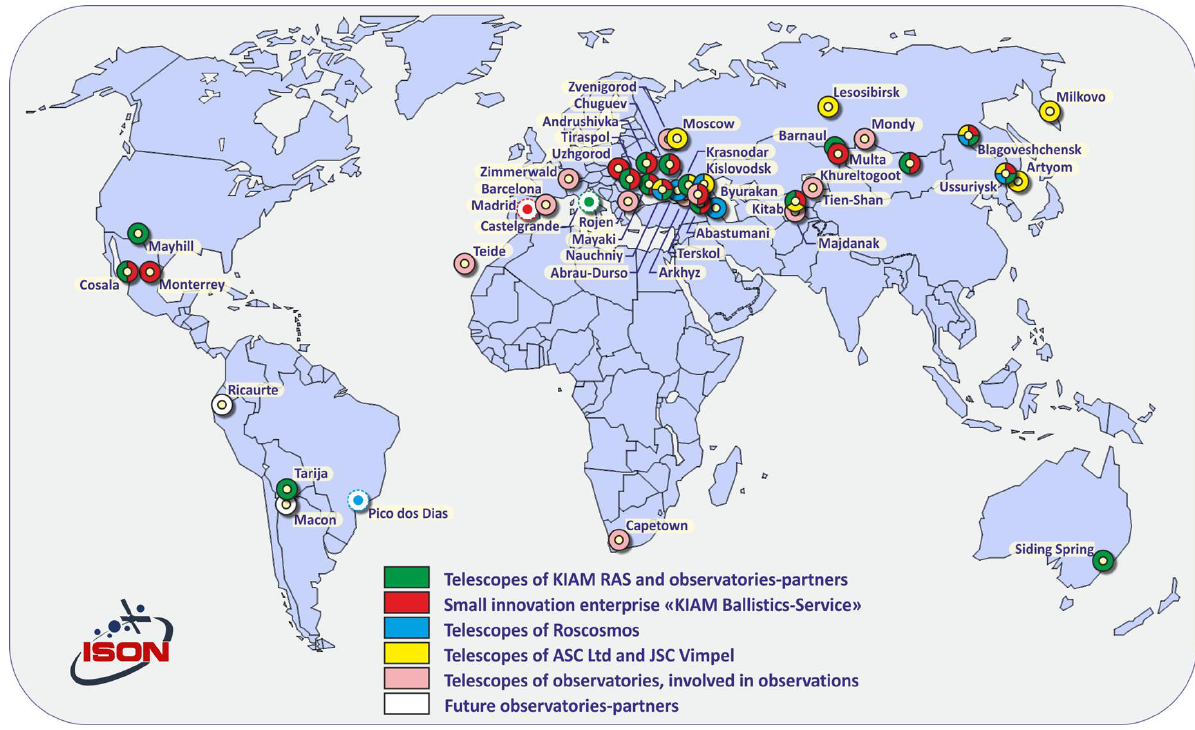
Figure 3. Location map of facilities aflliated with the ISON project.